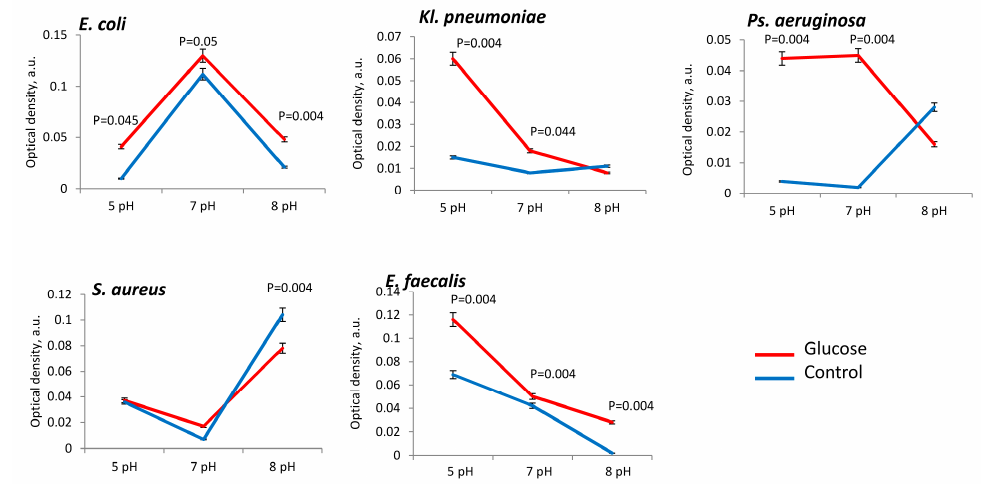
Figure 6. Bacterial metabolic activity is in fl uenced by pH and the presence of glucose in PBS.